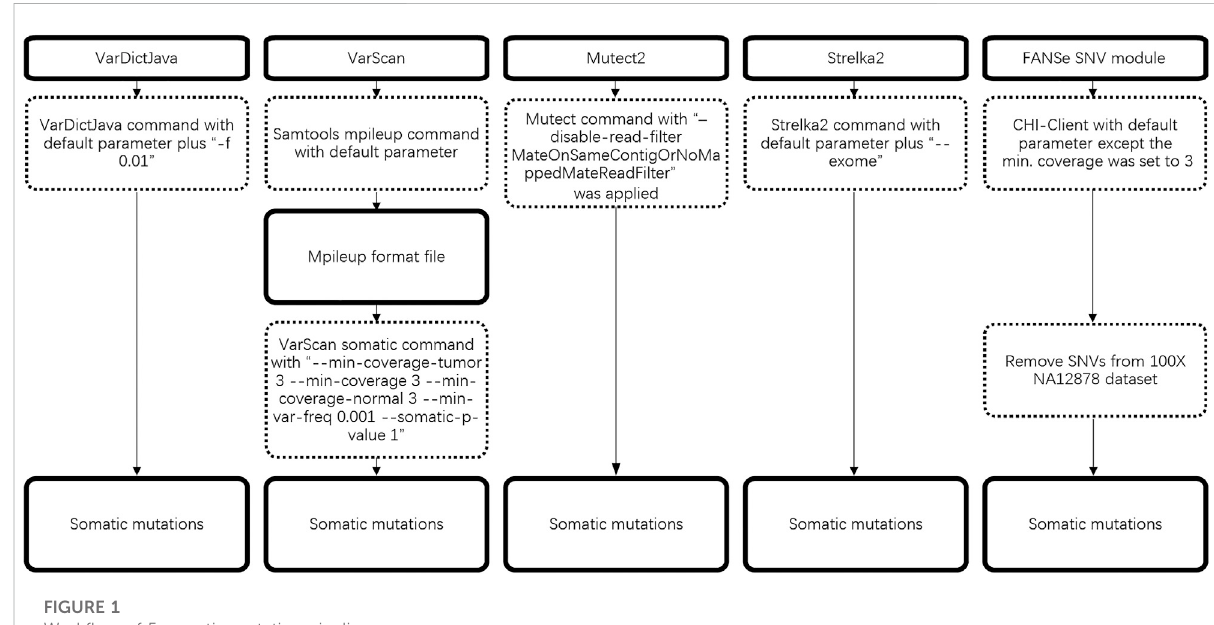
FIGURE 1 Work fl ow of 5 somatic mutation